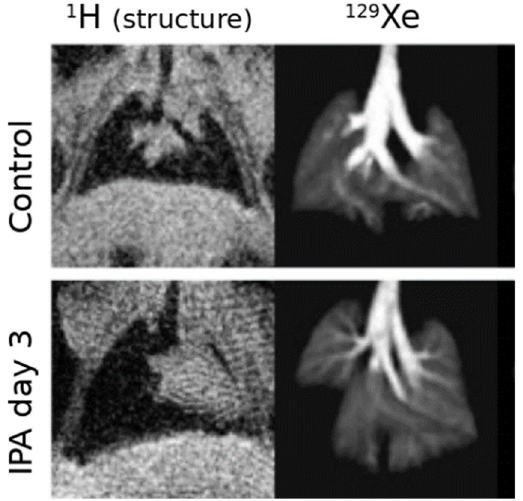
Figure 1. HXe images (right) in a mouse model highlight the obstruction of a major airway due to Invasive Pulmonary Aspergillosis (bottom). As is often the case, structural imaging (left) leaves ambiguity about the extent and location of obstruction, but the lack of signal in the unventilated region shows that the right inferior bronchus is completely occluded.